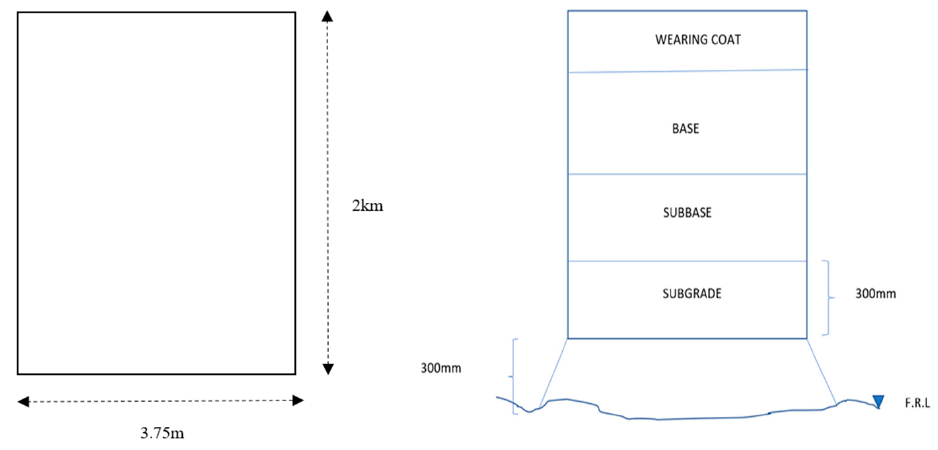
Figure 18. Typical cross-section of the assumed pavement subgrade.